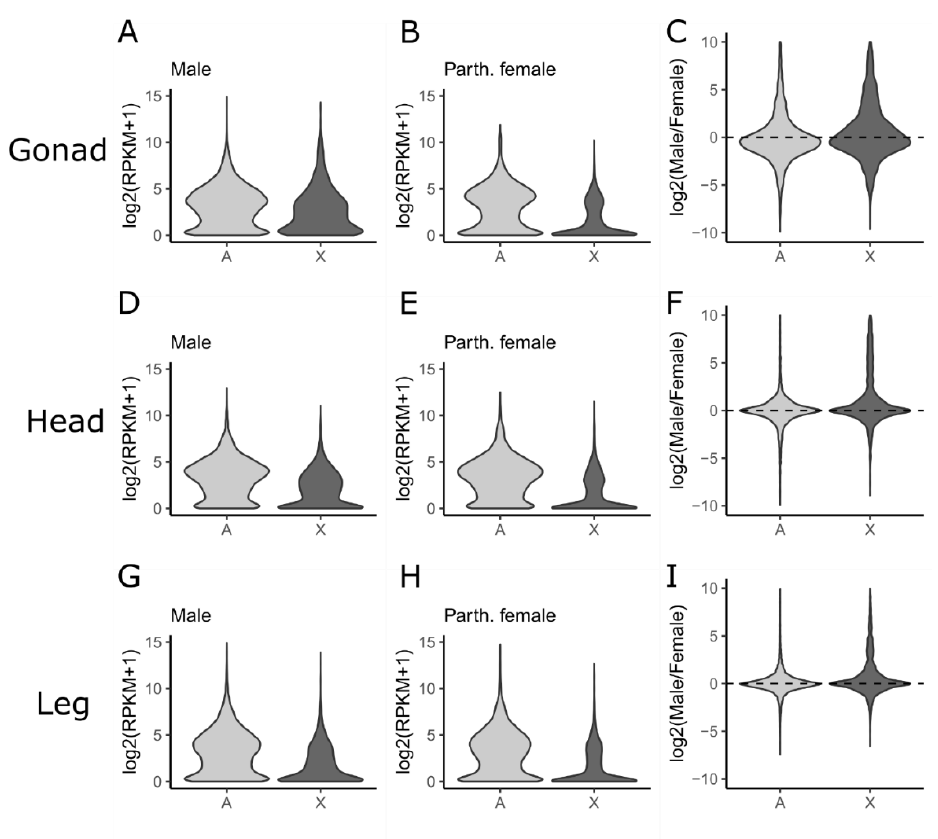
Supplementary figure S4: Logarithm of gene expression (RPKM+1) in males and parthenogenetic females for X-linked and autosomal genes in gonads (panels A and B), head (D, E) and legs (G, H). X-linked genes are significantly less expressed than autosomal genes in all cases (two-sided Mann-Whitney tests, p < 10 -15 ). Logarithm of male to parthenogenetic female ratio of RPKM is also shown for the three tissues (panels C, F and